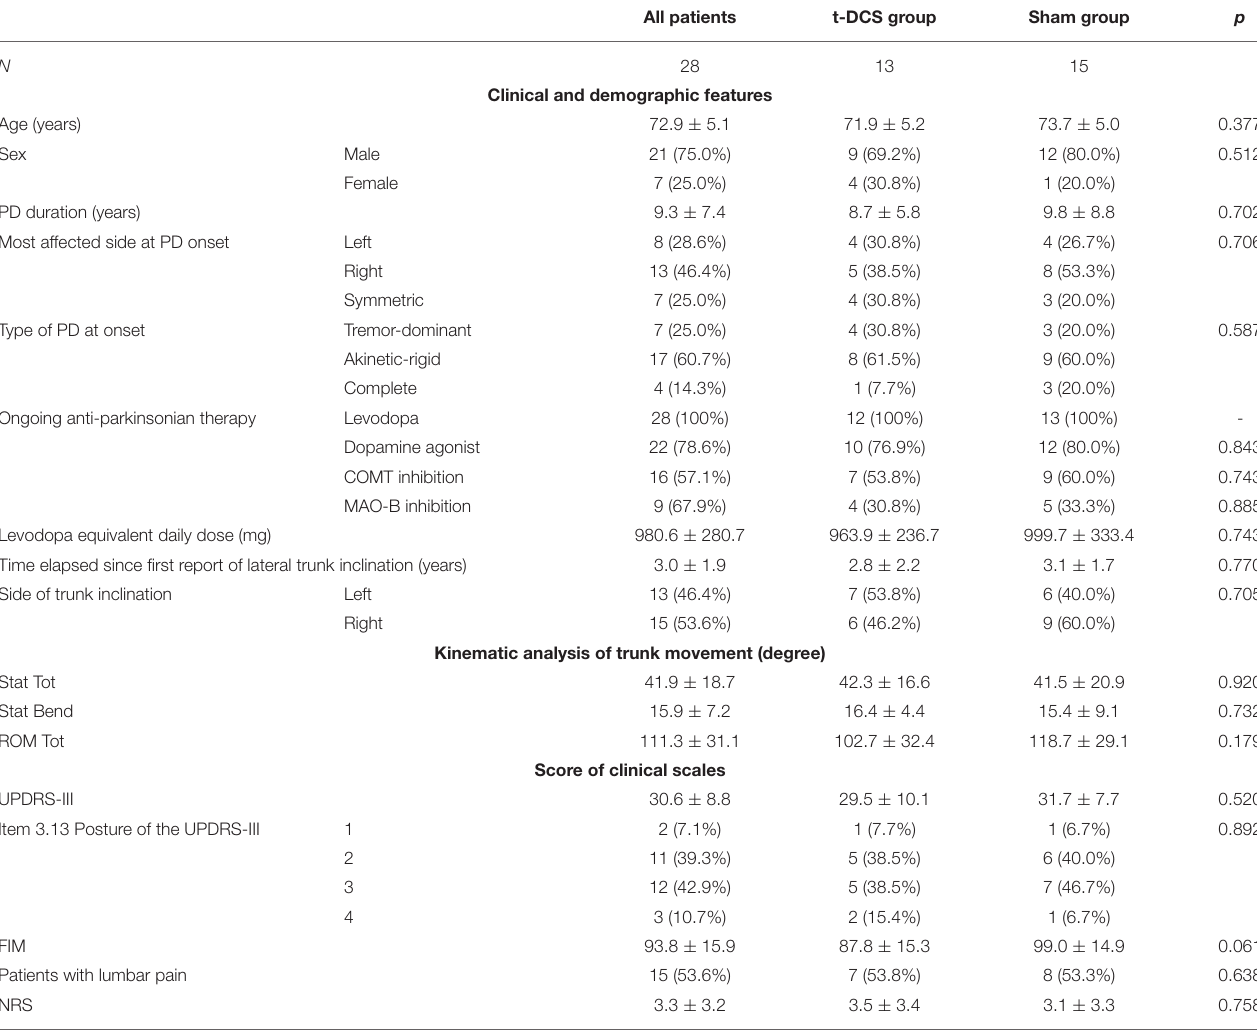
TABLE 1 | Clinical and demographic features, kinematic analysis of trunk movement, and scores of clinical scales of study populations at baseline. All patients t-DCS